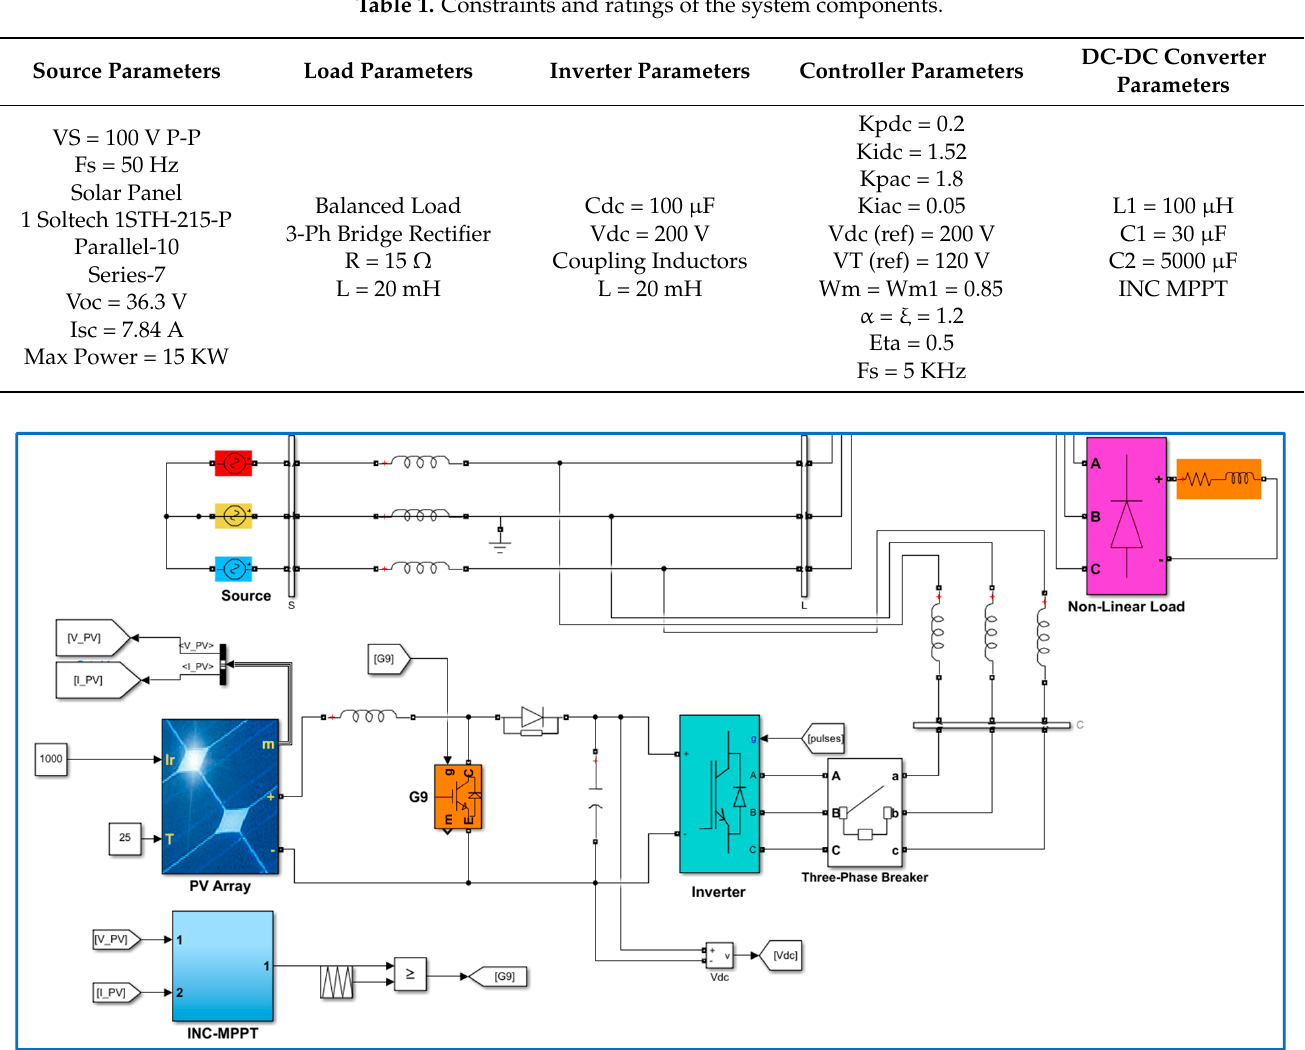
Table 1. Constraints and ratings of the system components.